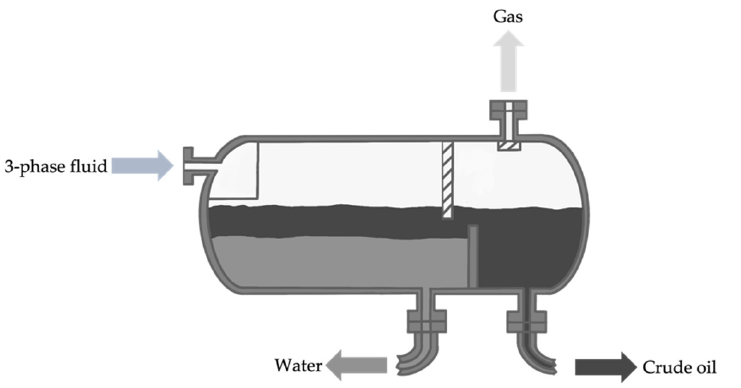
Table 2. FPSO specification [31].